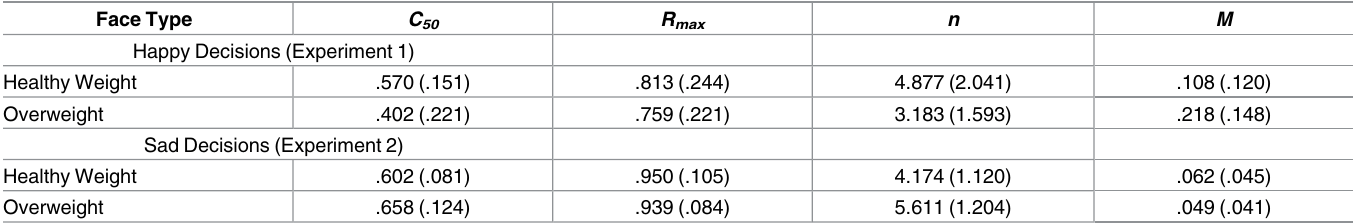
Table 3. Means and standard deviations of best-fit values of psychometric curve fit